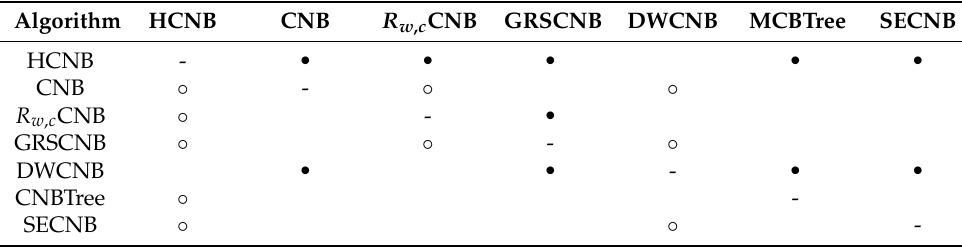
Table 6. Results of the Wilcoxon test with regard to HCNB.